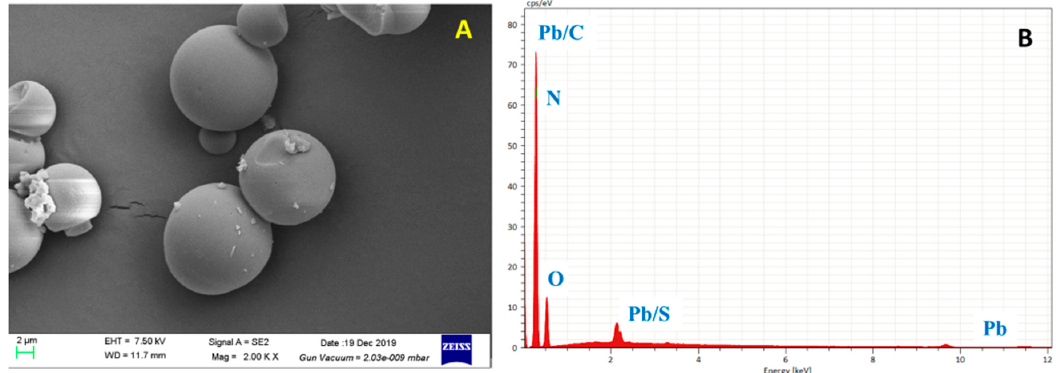
Figure 1. Image ( A ) and EDS ( B ) curve of honey hydrothermal biochar (HHTB) after adsorption of Pb 2+ .